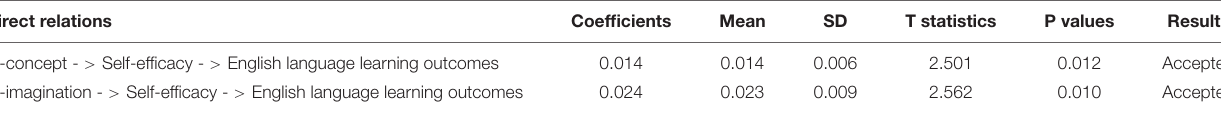
FIGURE 2 | Research out put model. TABLE 7 | Indirect